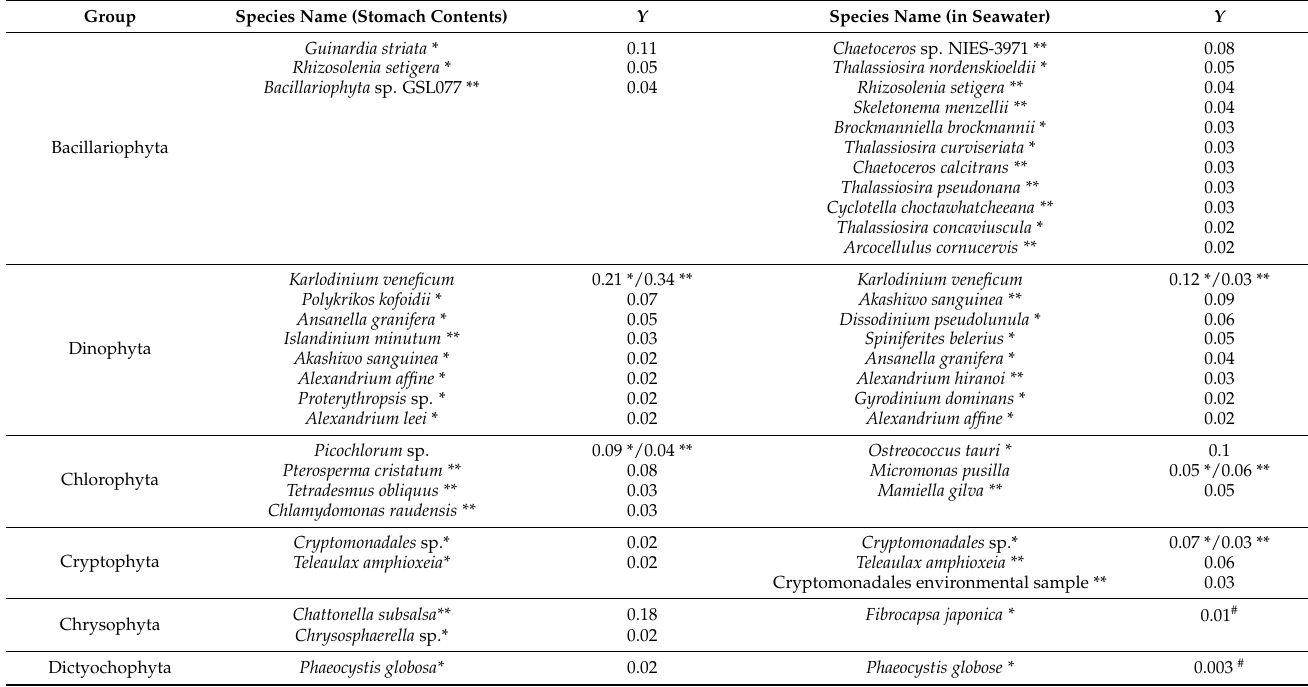
Table 2. Dominant species of various groups of phytoplankton in the stomach contents of R. philip- pinarum and water of the Yalu River Estuary in